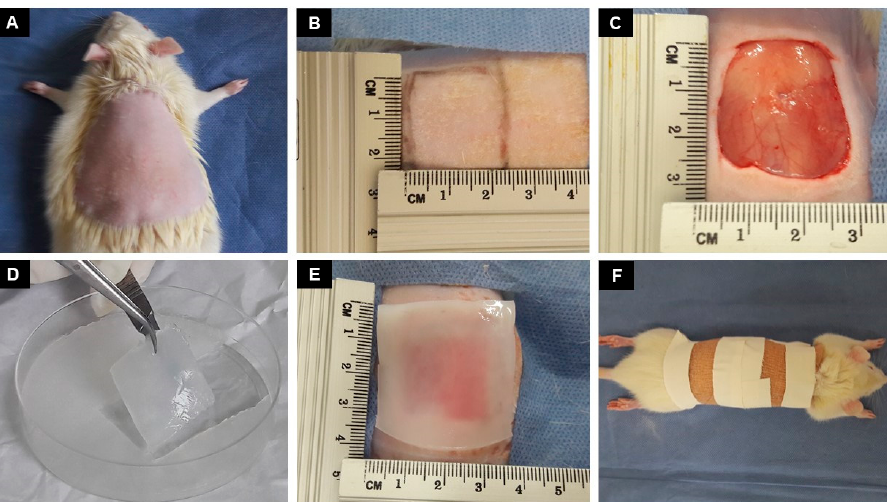
Figure 12. Images of the surgical procedure: ( A ) rat dorsal trichotomy; ( B ) definition of injury area; ( C ) dissected skin area; ( D ) sample membrane (PVA-AgNP in this image); ( E ) implanted area with the membrane; and ( F ) the dressing placed over the implant.